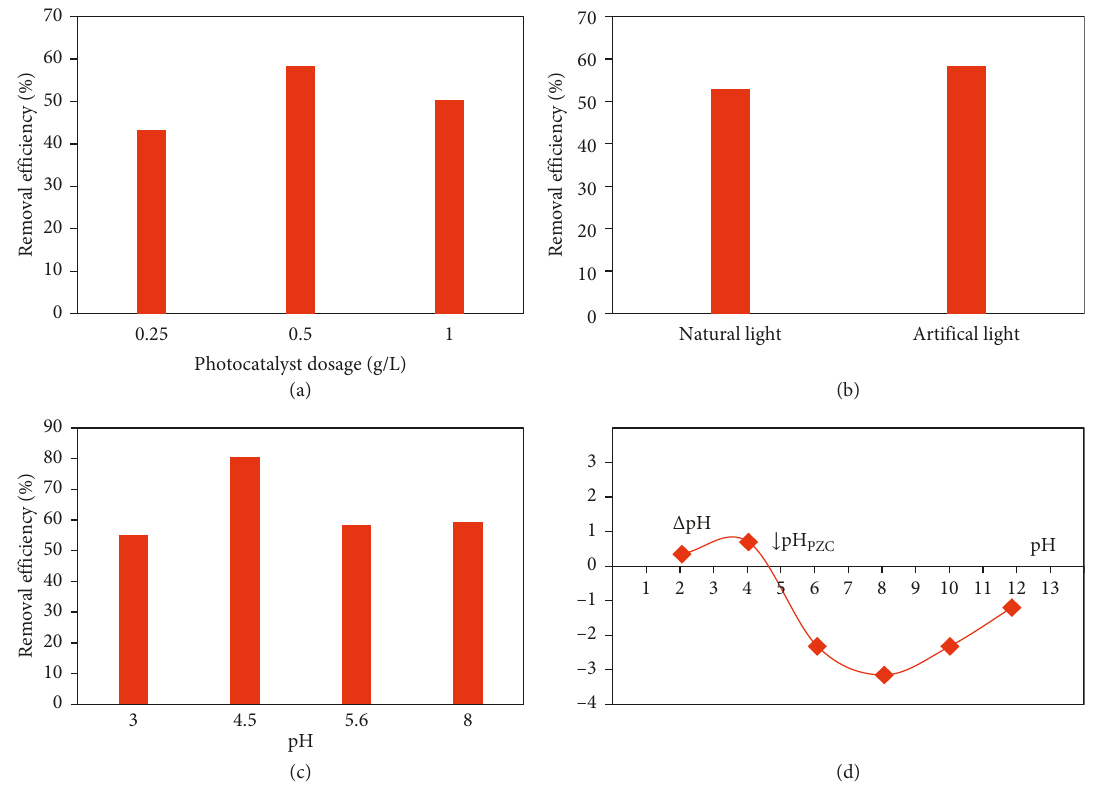
Figure 6: Effects of photocatalyst dosage (a), light sources (b), and pH (c) on diazinon removal efficiencies and zeta potential of the synthesized Fe-TiO 2 /Bent-Fe